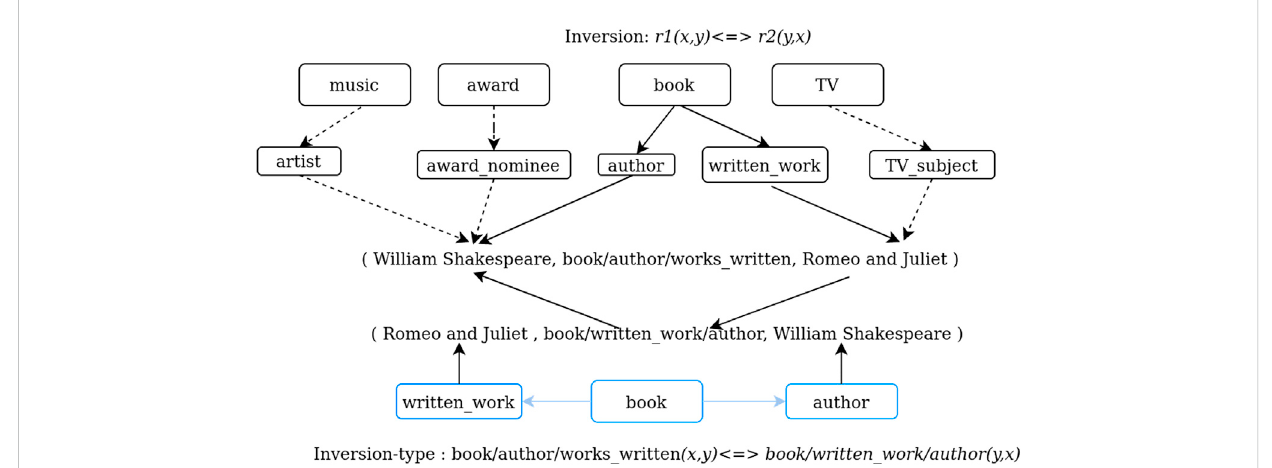
FIGURE 5 Example of logic relations with entity hierarchical types in